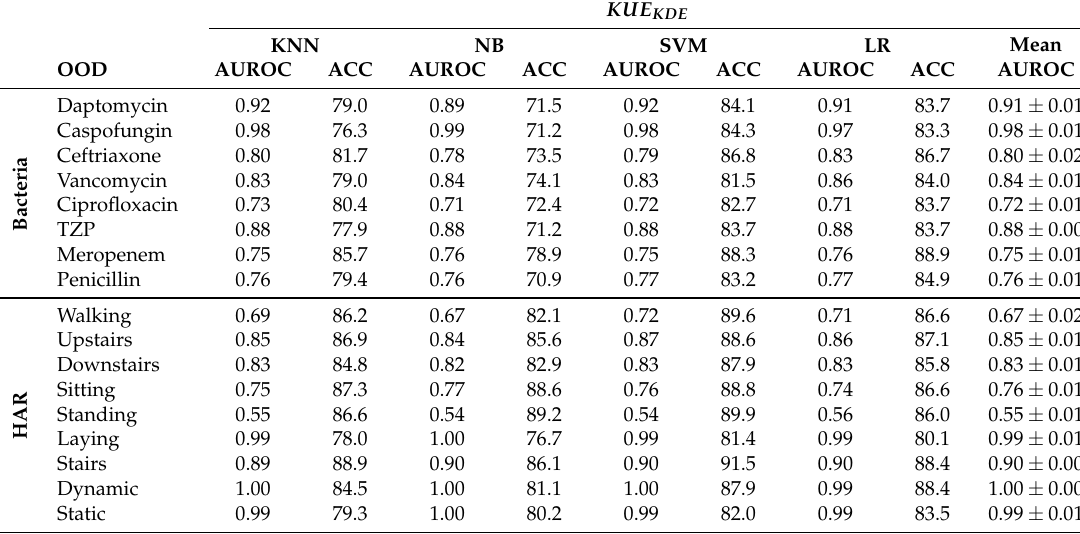
Table A2. AUROC for detecting OOD inputs using our KUE method with KDE applied to 4 different classifiers and the correspondent accuracy (ACC) in % of the classifiers on 4 datasets. All values are averages over 10 consecutive